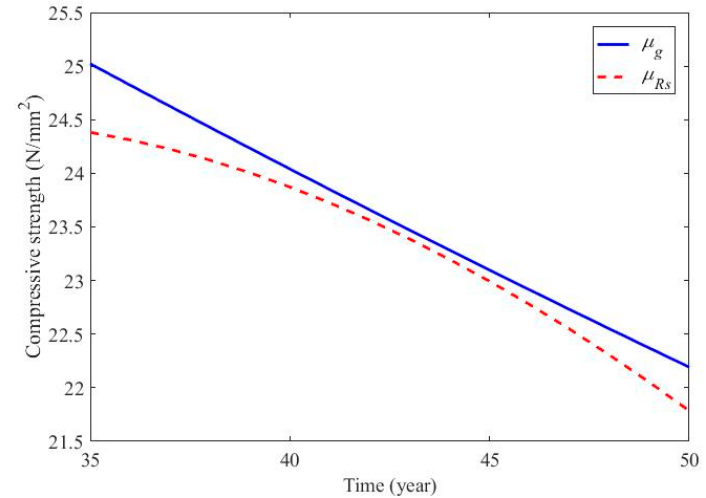
Figure 13. Comparison of results calculated by µ Rs and µ g ( f c = 18.0 N/mm 2